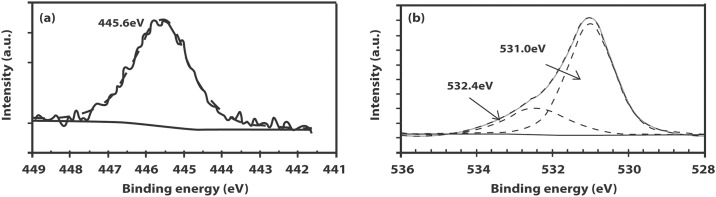
XPS spectra of the (a) In 3d5/2 peak (b) O 1s peak.